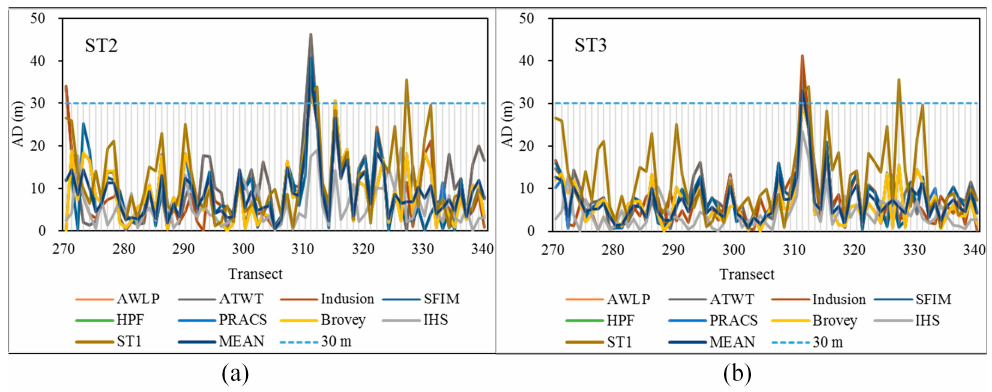
Figure 9. Results of AD for different images from transect 270 to 340. ( a ) AD of strategy 2; ( b ) AD of strategy 3.